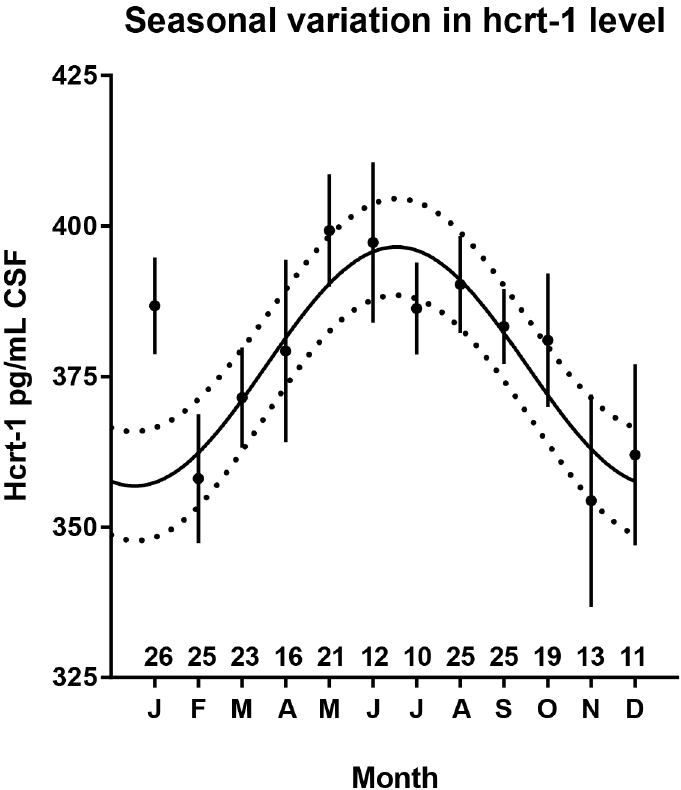
Fig 1. Seasonal variation in CSF hcrt-1 levels in human individuals. Sinusoidal fitted curve to monthly average of patient CSF hypocretin-1 levels, excluding January. Dashed lines represent 95% confidence interval. The inserted numbers above x-axis equals the number of data points for each month.